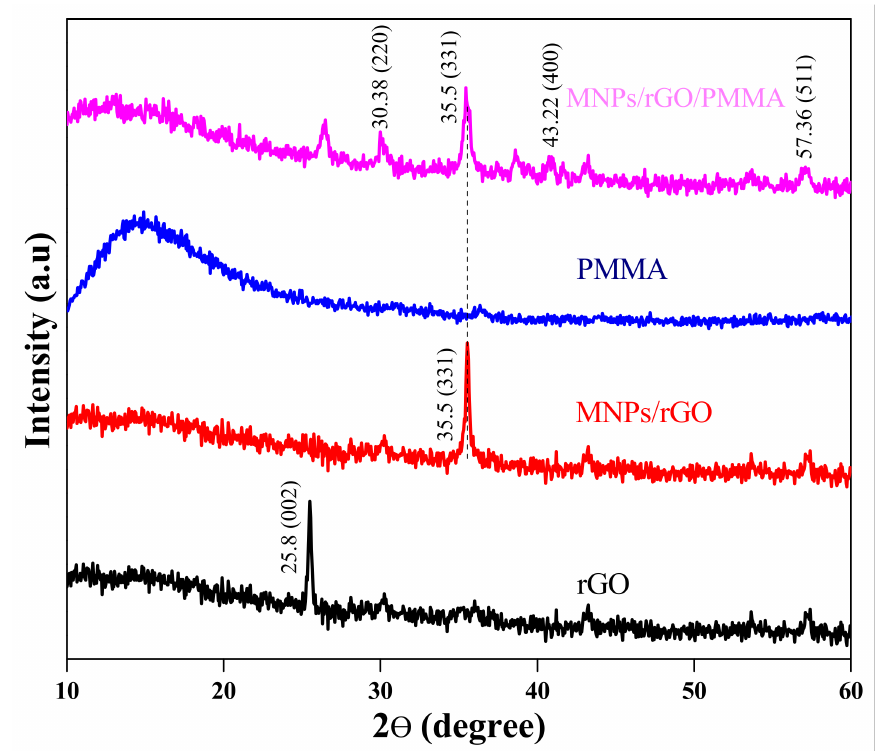
Figure 2. XRD spectra of rGO, Fe 3 O 4 /rGO, PMMA and MNPs/rGO/PMMA.